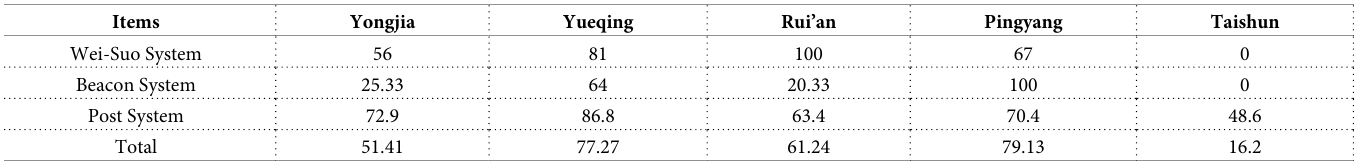
Table 11. Final scores